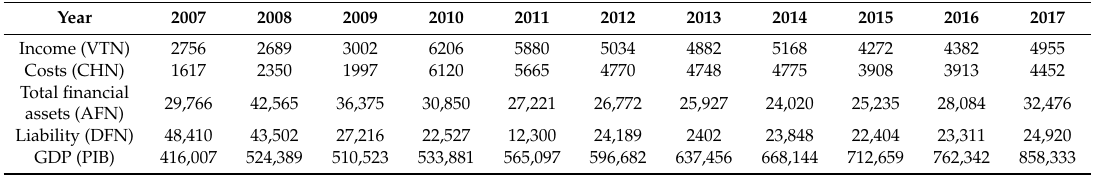
Table 3. Absolute values of primary indicators (million RON 1